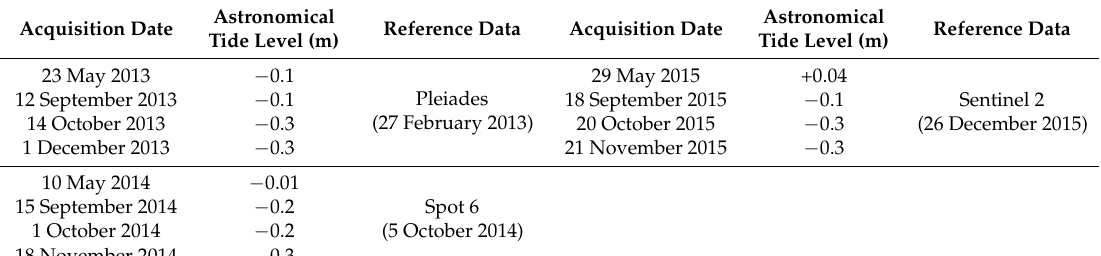
Table 1. Landsat 8 OLI/TIRS images captured in the low tides supplemented by tide level and reference images used in the accuracy assessment purpose for each period.